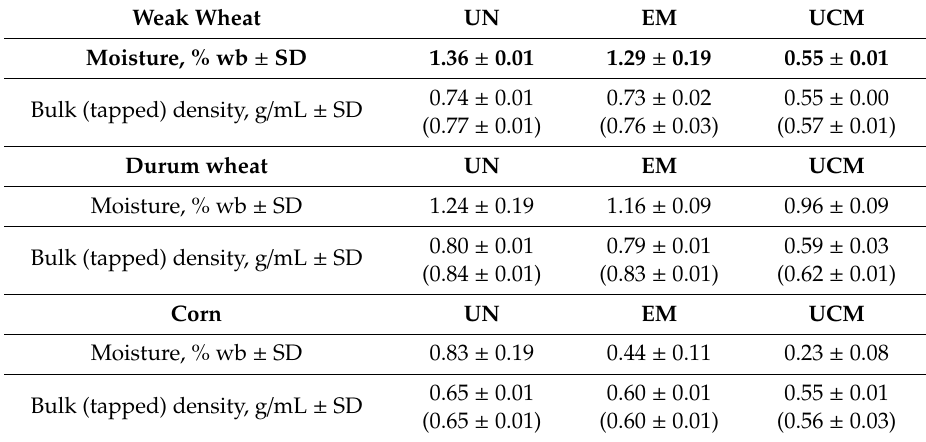
Table 1. Moisture content, bulk density, and tapped density for untreated (UN), effective treated (EM), and uncontrolled treated (UCM) seeds of weak wheat, durum wheat, and corn (standard deviation